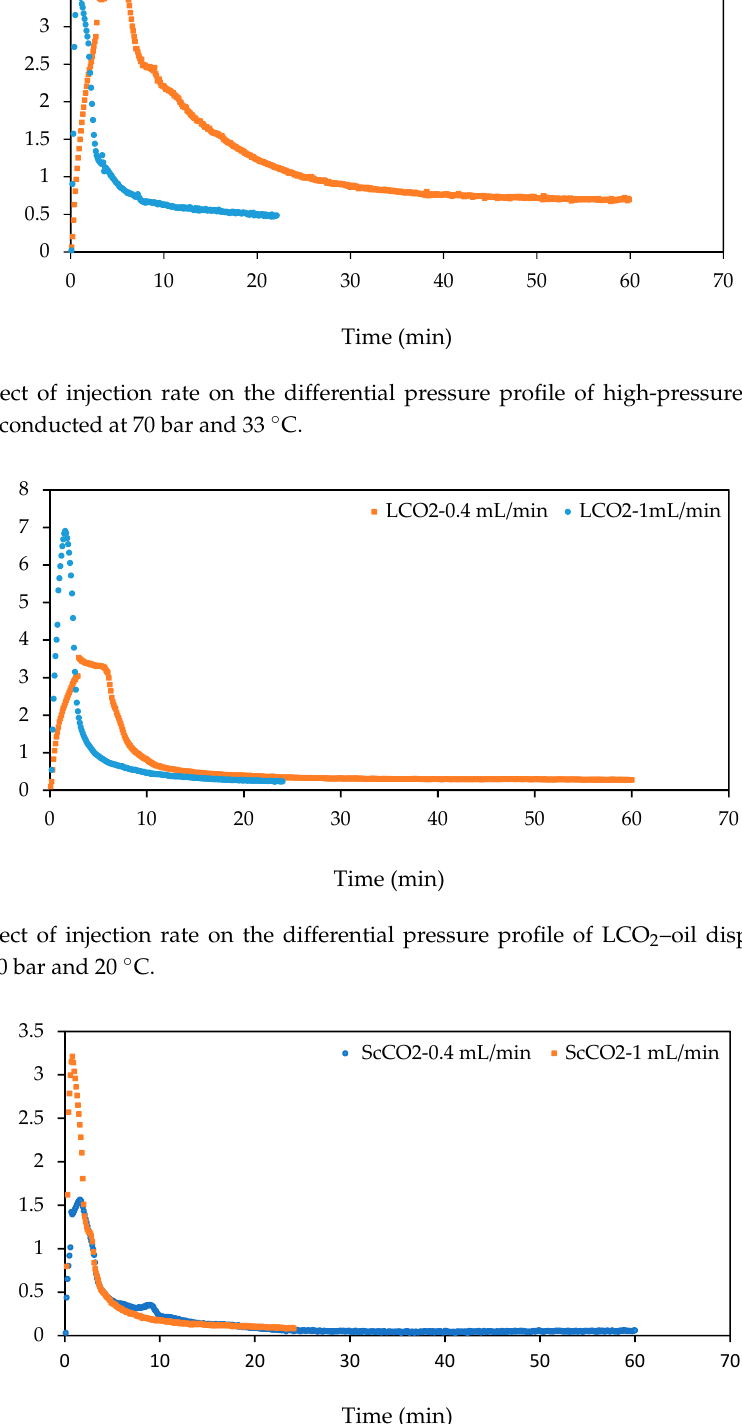
Figure 16. Effect of injection rate on the differential pressure profile of ScCO 2 –oil displacements conducted at 90 bar and 33 °C.